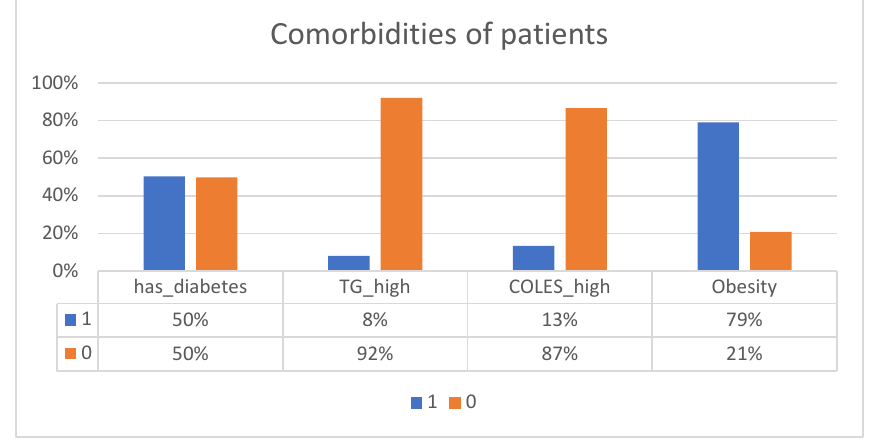
Figure 1. Comorbidities of patients.